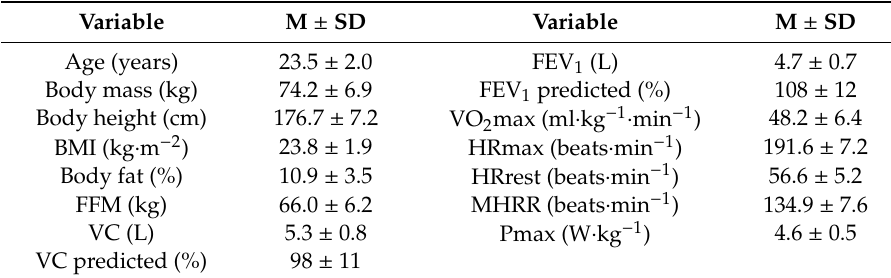
Table 1. Anthropological and physiological characteristics of the participants ( n =